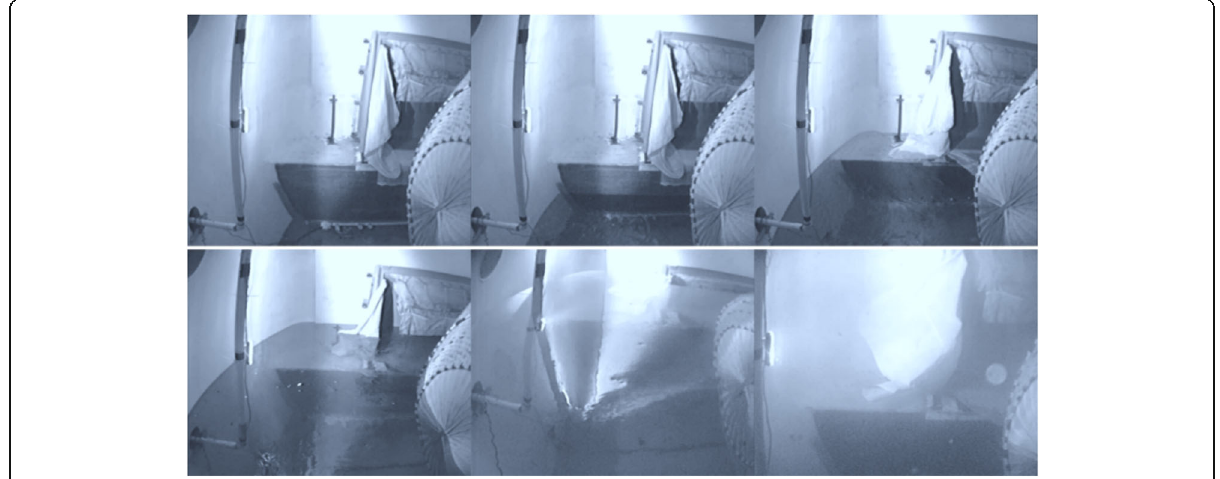
Fig. 12 Phase 2b-ET, full-scale testing, three-layer Vectran plug: Back view during filling of tunnel cavity for flooding simulation [69,